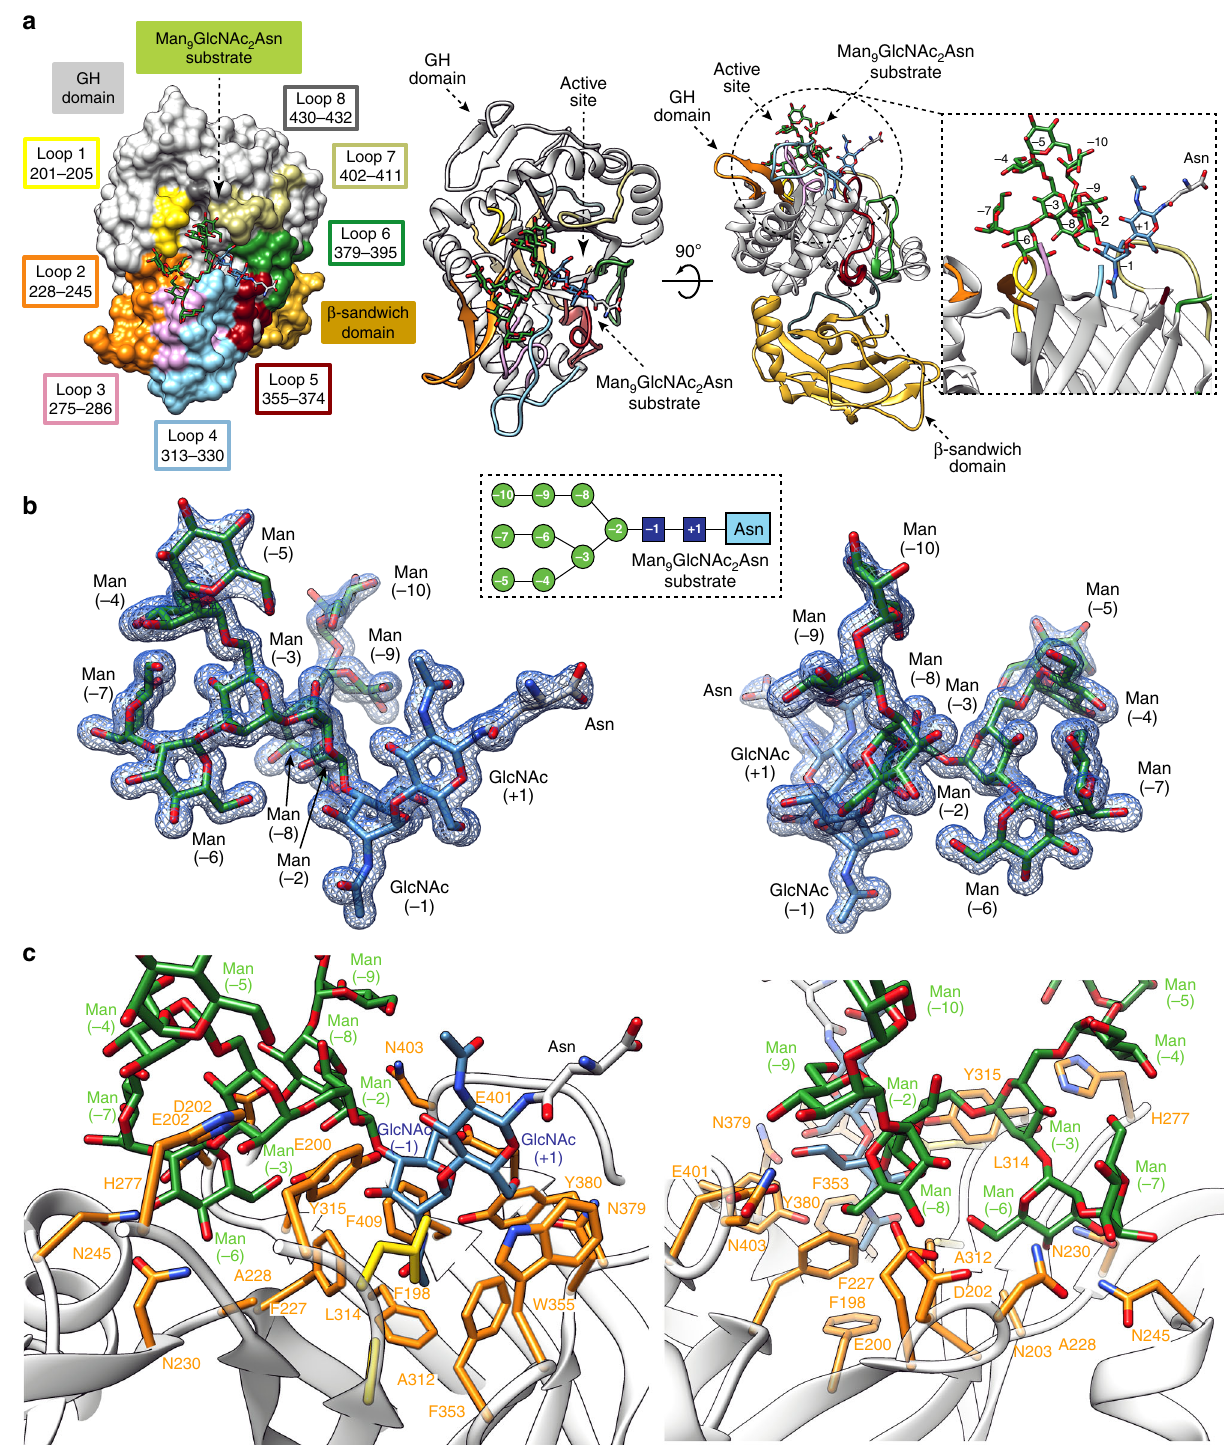
Fig. 2 The overall structure of EndoBT-3987 and the substrate Man 9 GlcNAc 2 Asn glycan binding site. a Surface representation (left) with annotated domains and GH loops and cartoon representation (center) of two views of the EndoBT-3987 D312A/E314L -Man 9 GlcNAc 2 Asn crystal structure. On the right panel zoom in of the carbohydrate-binding site of Man 9 GlcNAc 2 Asn. b Two views of the electron density of Man 9 GlcNAc 2 Asn substrate shown at 1.0 σ r. m.s deviation. c Two views of the key residues of EndoBT-3987 interacting with Man 9 GlcNAc 2 Asn substrate are colored in orange. The mutated catalytic residues D312A and E314A are colored in